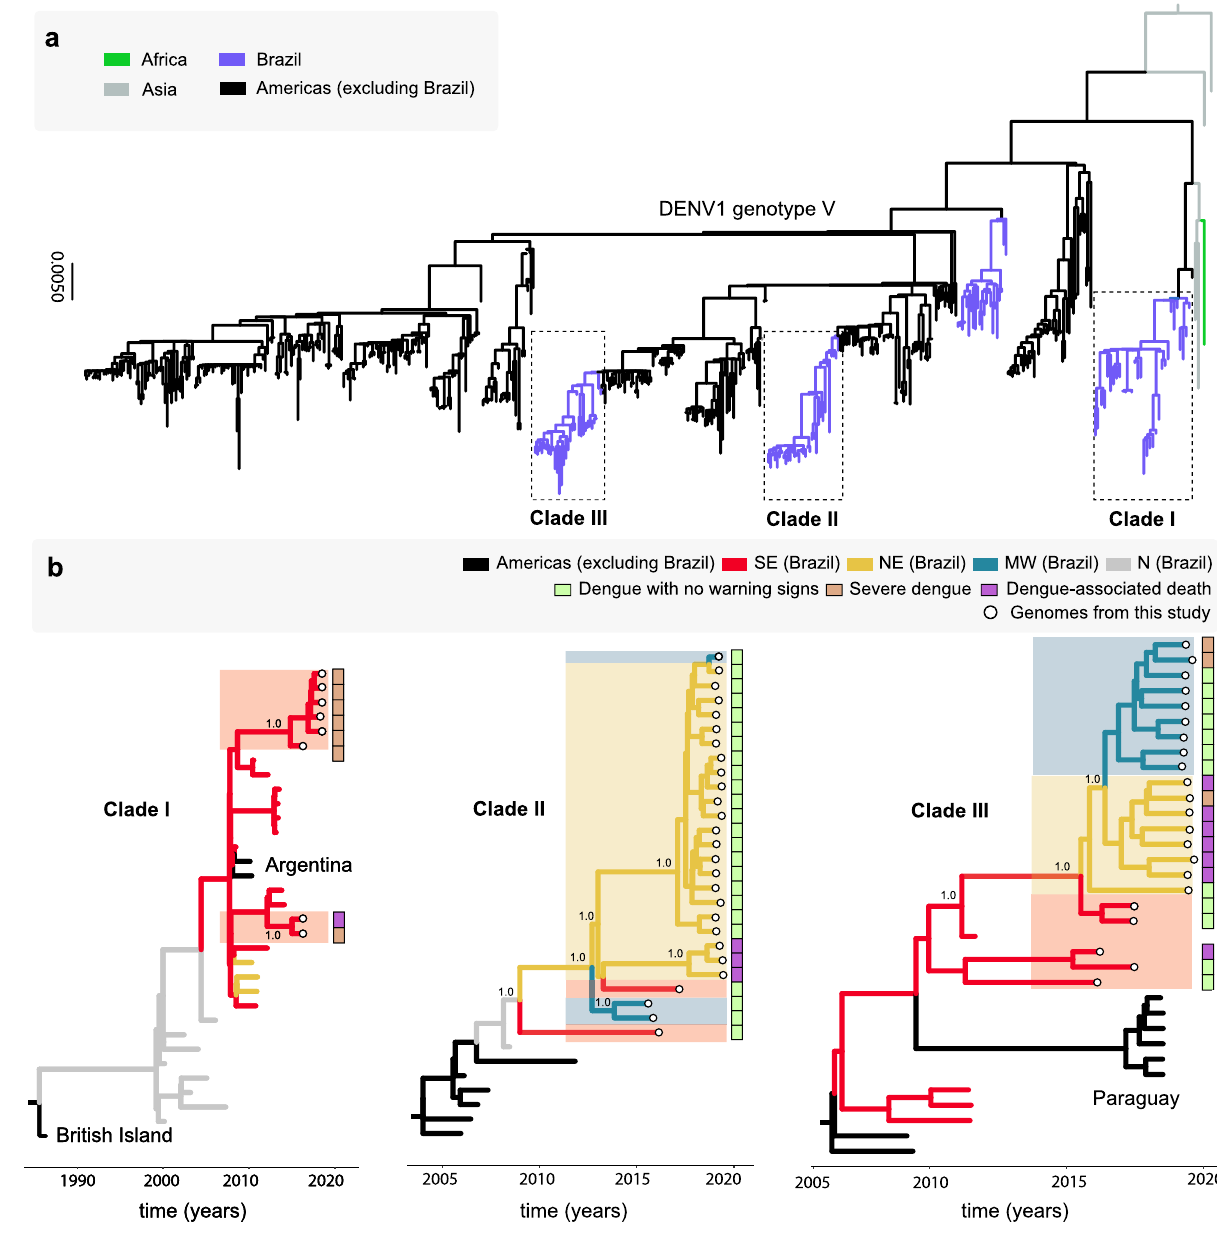
Fig. 2 Phylogenetic analysis of DENV1-V in Brazil. a Maximum likelihood (ML) phylogenetic analysis of 57 complete genome sequences from DENV1 generated in this study plus 444 publicly available sequences from GenBank. The scale bar is in units of nucleotide substitutions per site (s/s) and the tree is mid-pointed rooted. Colors represent different sampling locations. b Time-scaled phylogeographic tree of Clade I (including eight new sequences plus 25 GenBank sequences), Clade II (including 27 new sequences plus seven GenBank sequences), and Clade III (including 22 new sequences plus 12 GenBank sequences). Colors represent different sampling locations (SE Brazil = Brazilian Southeast, NE Brazil = Brazilian Northeast, MW = Brazilian Midwest, N Brazil = Brazilian North). Tip circles represent the genome sequences generated in this study; colored sidebars represent the dengue clinical classi fi cation for each sequenced